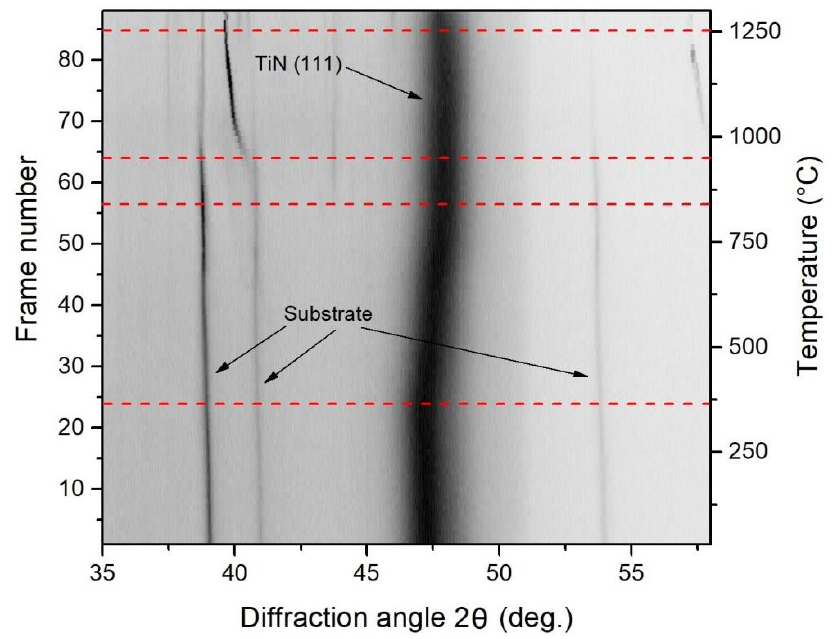
Figure 11. SXRD of the phase composition of the Ti 0.61 Al 0.39 N coating during heating to 1300 °C in air. λ = 0.172 nm.